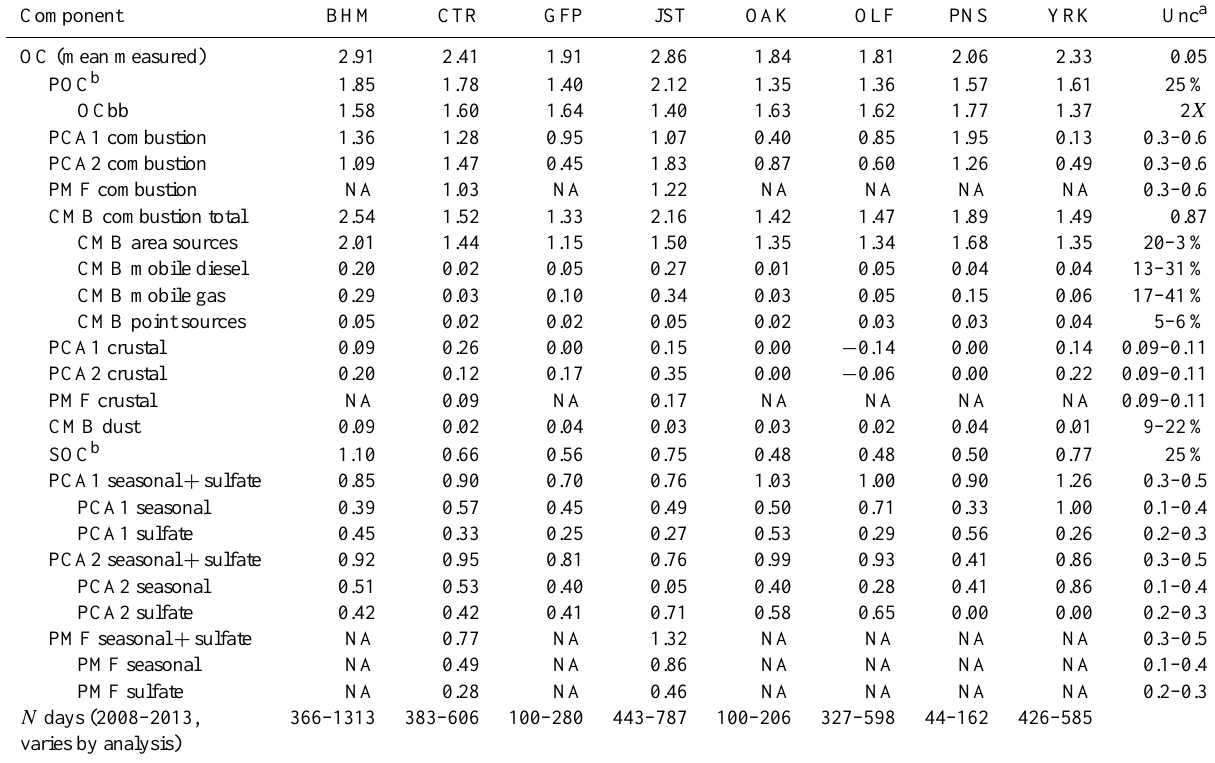
Table 5. Mean OC concentrations determined for the period 2008–2013 using four analytical approaches: (1) multivariate regression (POC and SOC; Blanchard et al., 2008), (2) calculation of OCbb from Kbb tracer, (3) PCA and PMF analysis, and (4) CMB receptor modeling (Blanchard et al., 2013, updated). Row indentations indicate subcategories. Units are µgm − 3 unless specified as %.